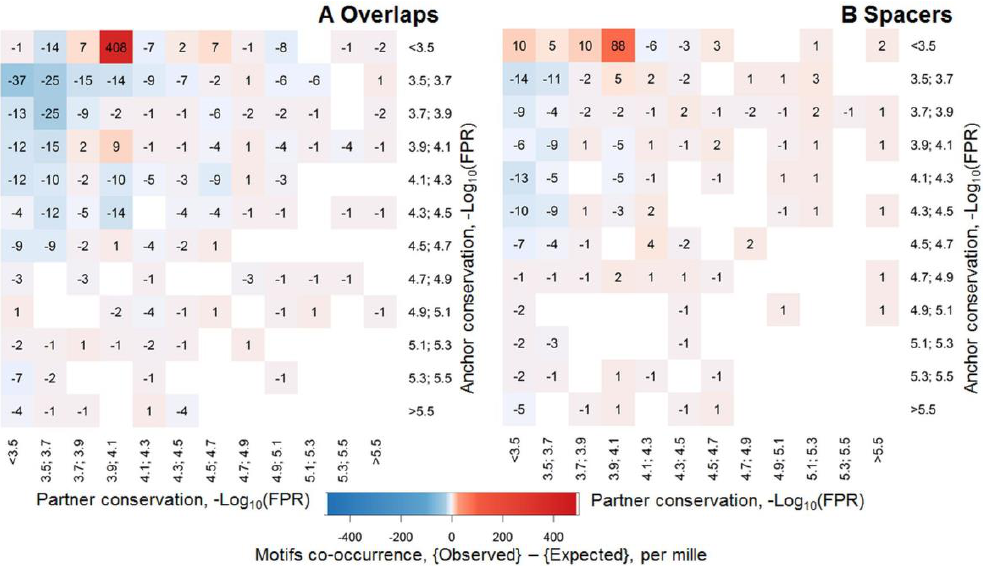
Figure 2. The difference between observed and expected abundances of CEs with specific conservation of the anchor FoxA2 (axis Y) and partner HNF1β (axis X) motifs for ChIP -seq data [15] in per mille. The conservation of motifs was measured as -Log 10 (FPR) (logarithmic false positive rate (FPR), Section 4.2). The color on both heatmaps shows the difference between observed (peaks) and expected (permuted sequences) relative abundance of CEs with specific conservation levels (Section 4.3 ). FoxA2 and HNF1β motifs were der ived from the Homer de novo motif search [8] and Hocomoco database (HNF1B_Mouse.H11MO.0.A) [14], respectively. Panels ( A ) and ( B ) show asymmetry of CEs with an overlap of motifs and with a spacer, respectively.